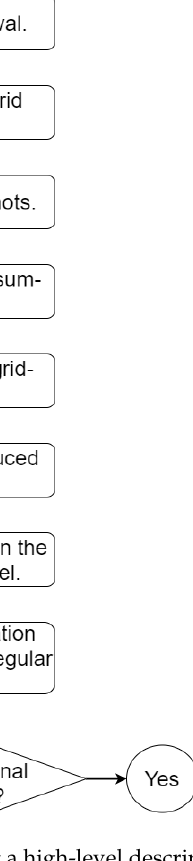
Figure 1. A flowchart providing a high-level description of